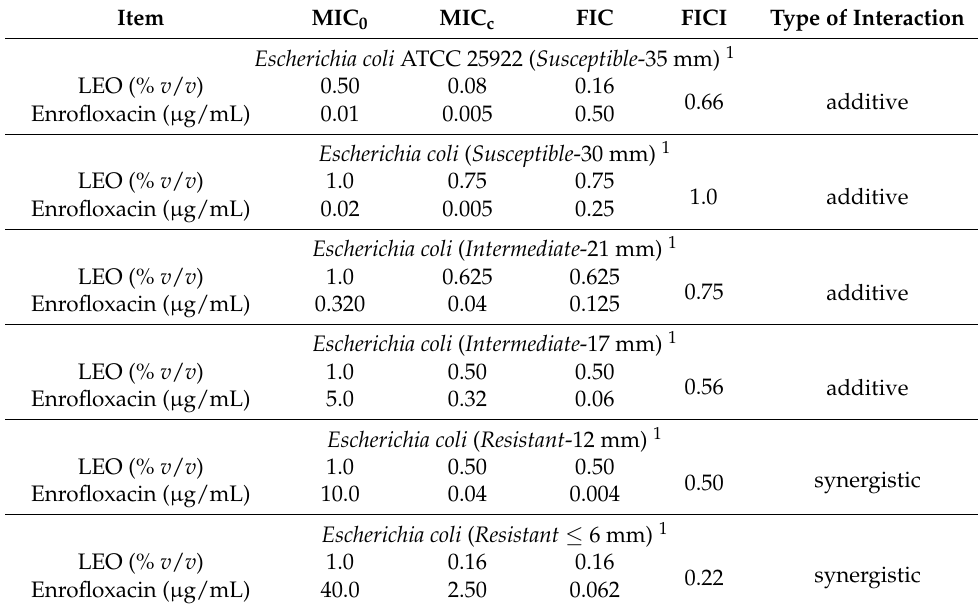
Table 4. Lavender essential oil (LEO) in combination with enrofloxacin—Fractional Inhibitory Concentration (FIC) and FIC Indices